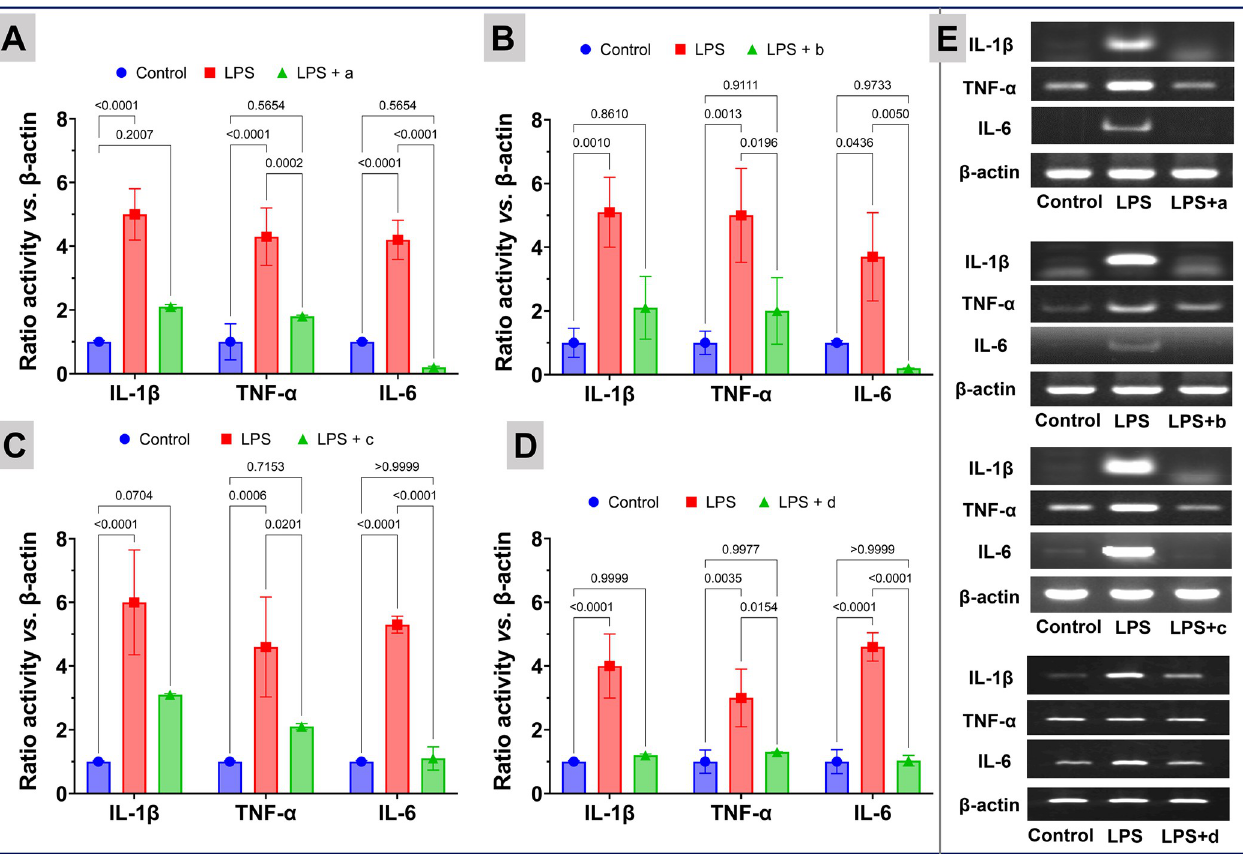
Fig 4. Impact of the nanoparticles on transcription of pro-inflammatory genes: Co-treatment of Cur-Ag (Panel A), Cur-Ag INH (Panel B), Cur-Ag Tyr (Panel C), and Cur-Ag Qrc (Panel D) nanoparticles with lipopolysaccharides (LPS) on the activation of pro-inflammatory cytokines (TNF- α , IL-6, and IL-1 β ) expression on mouse Raw 264.7 macrophages; β -actin acts as a standard. In Panels A, B, C, and D, the results are expressed as mean ± SD. The data shown is a compilation of three independent trials. P-values are shown above the square brackets; p < 0.05 was considered statistically significant.